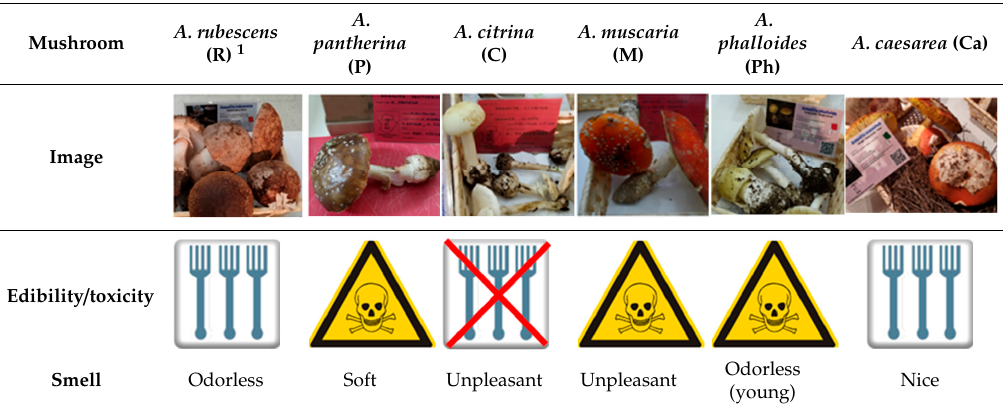
Table 1. Edibility / toxicity and aroma of the Amanita species analyzed.